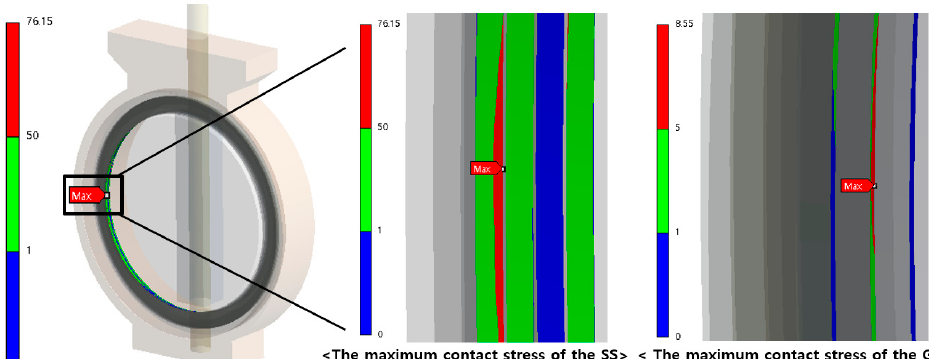
Figure 22. Contact stress distribution of design 4.